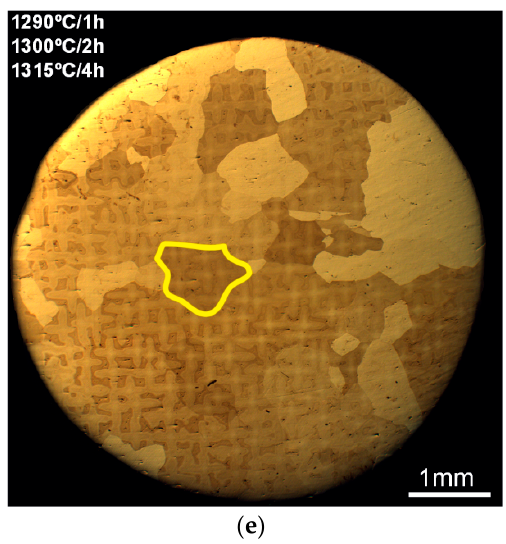
Figure 5. Microstructural evolution of S-980 during SSHT procedure. ( a ) S-980-1; ( b ) S-980-2; ( c ) S-980-3; ( d ) S-980-4; ( e ) S-980-5.